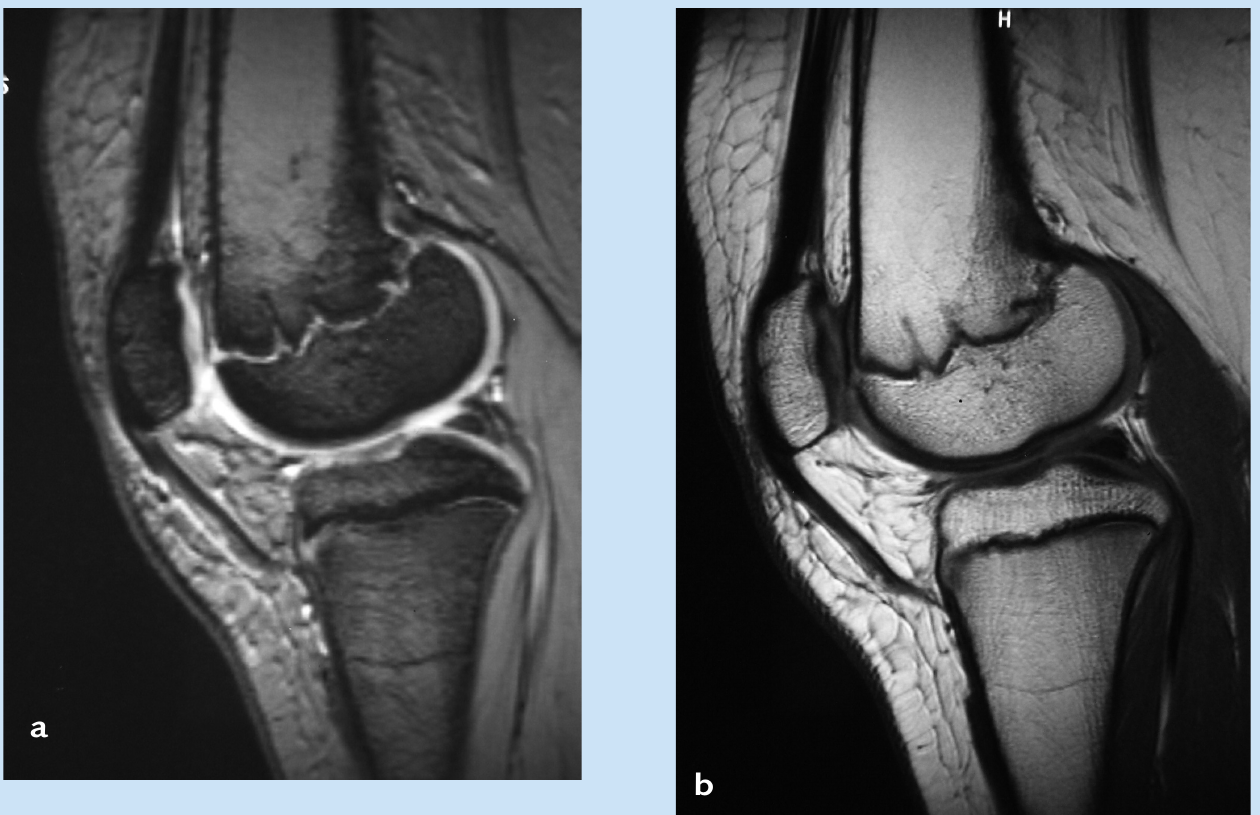
1. Ecklund K, Jaramillo D. Patterns of premature physeal arrest: MR imaging of 111 children. AJR 2002;178: 967-972. 2. Borsa JJ, Peterson HA, Ehman RL. MR imaging of physeal bars. Radiology 1996; 199(3): 683-687. 3. Craig JG, Cramer KE, Cody DD, et al. Premature partial closure and other deformities of the growth plate: MR imaging and three dimensional modeling. Radiology 1999; 210(3): 835-843. 4. Lohman M, Kivisaari A, Vehmas T, Kallio P, Puntila J, Kivisaari L. MRI in the assessement of growth arrest. Pediatr Radiol 2002; 32: 41-45. 5. Grogan DP, Love SM, Ogden JA, Millar EA, Johnson LO. Chondro-osseous growth abnormalities